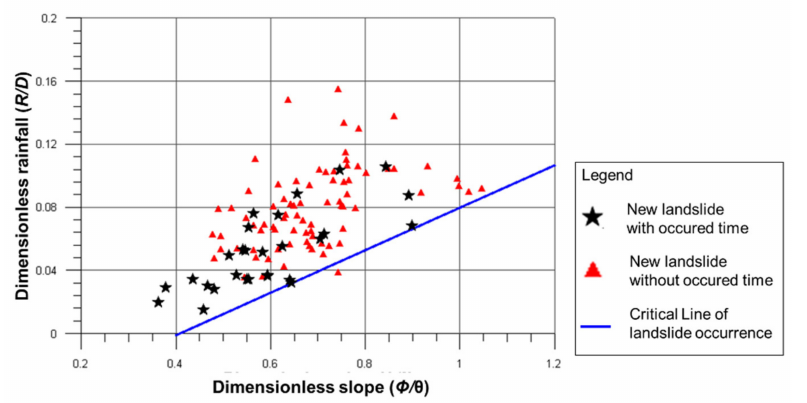
Figure 11. Relationship between envelope of fitting curve and occurred large-scale landslides.